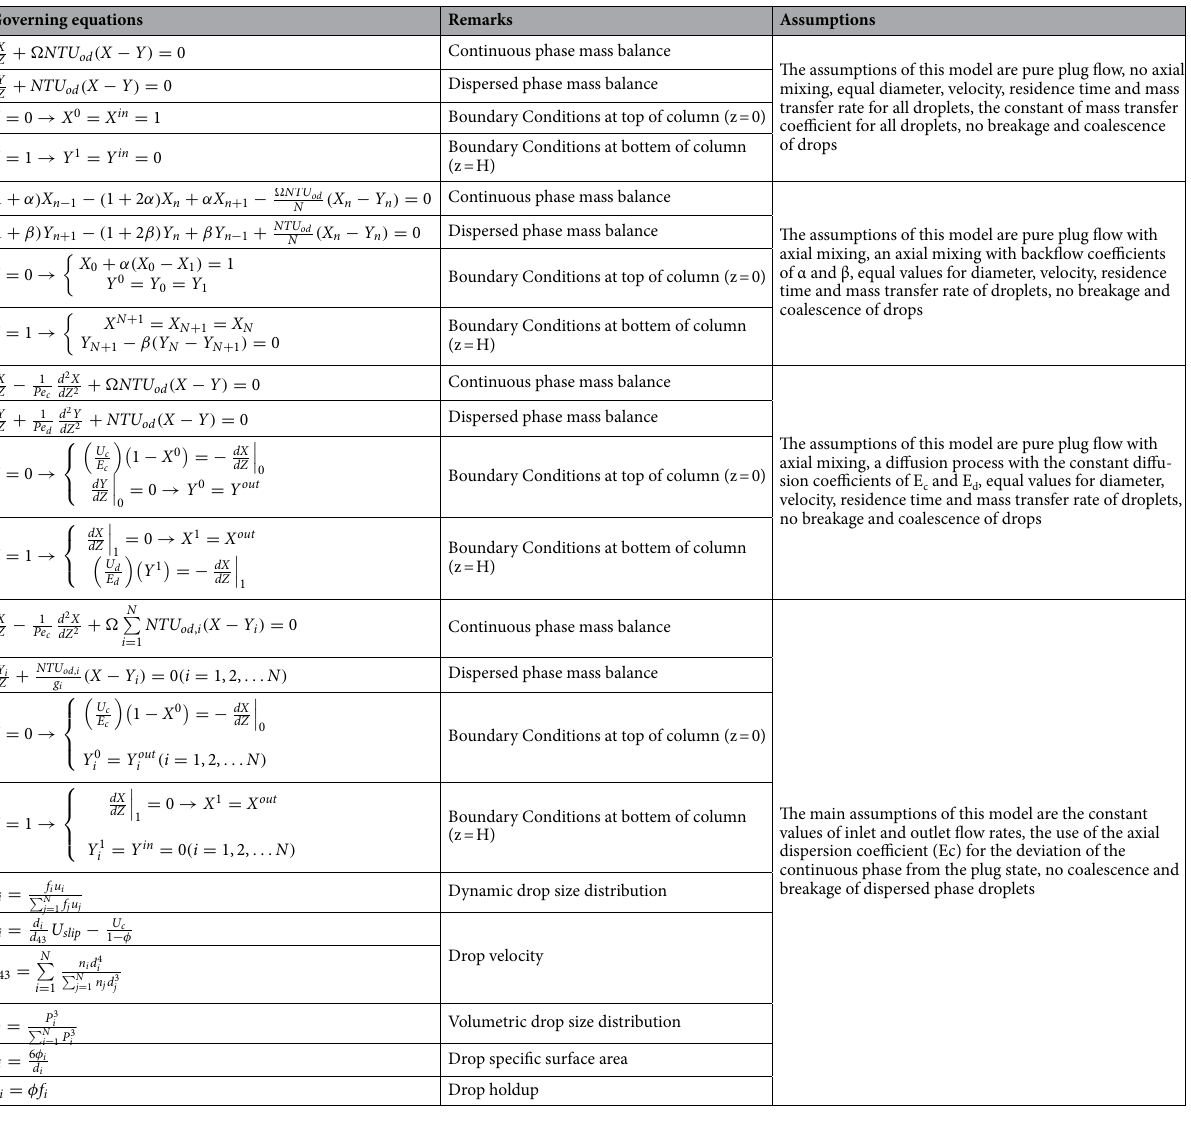
Table 1. Mass balance equations for four models 31